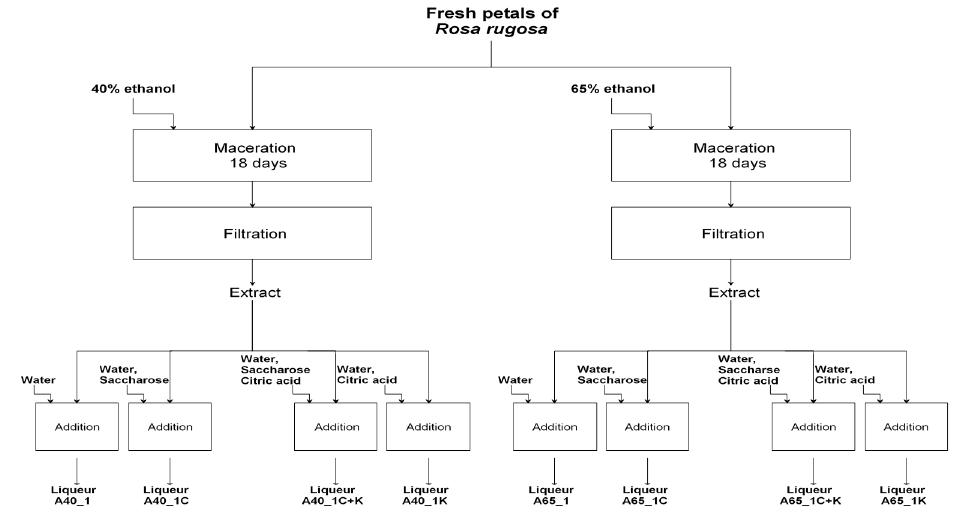
Figure 1. Diagram of the technological operations for liqueurs prepared from non-acidified Rosa rugosa petal extract.